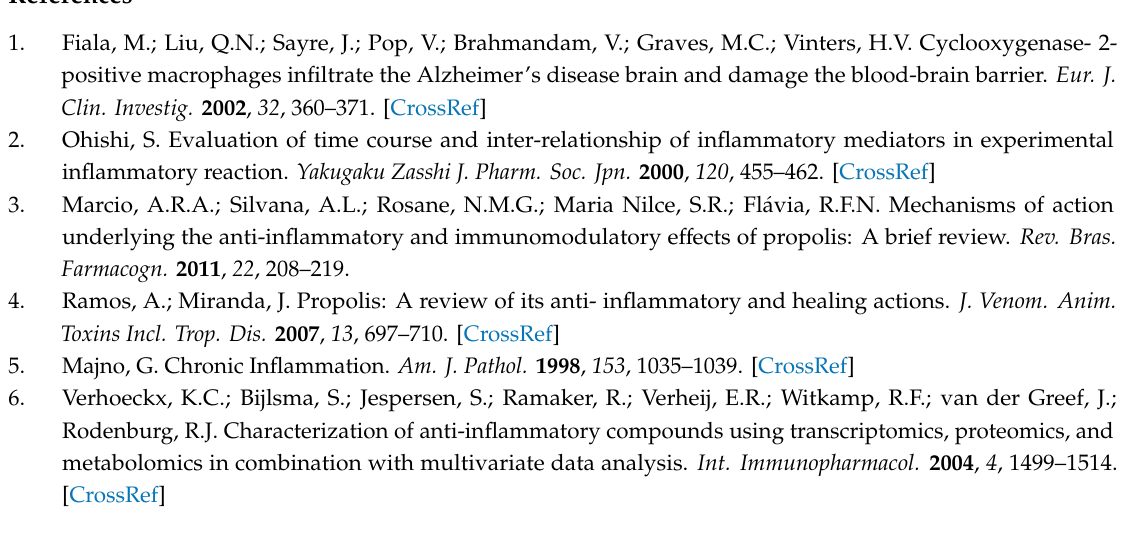
Figure S1: Cytotoxic E ff ect of propolis samples on THP-1 cells, Figure S2–S13: Showing a representative 4-parameter logistic plot of TNF- α , IL-1 β , IL-6, and IL-10 standard samples, Figure S14: The log2- fold change between P-C + LPS and LPS alone in THP-1 cells, Table S1-S4: E ff ect of propolis samples on the production of TNF- α , IL-1 β , IL-6, and IL-10 cytokines in the presence and absence of LPS, Table S5: List of abbreviations, Table S6: List of catalog / serial numbers of instruments and